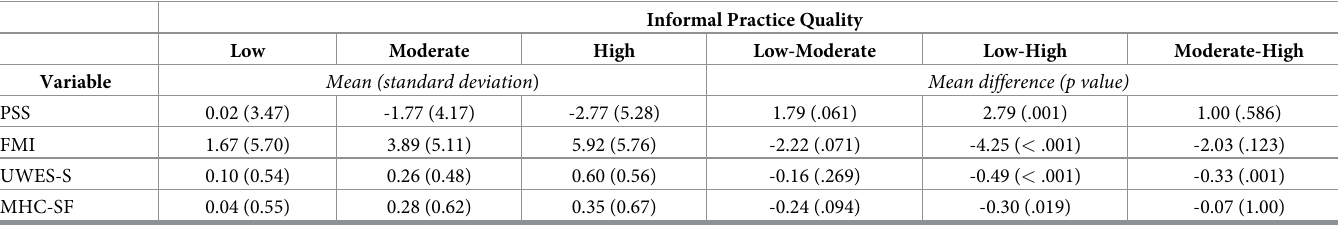
Table 4. Descriptive and inferential statistics for post hoc comparisons for low, medium, and high adherence to informal mindfulness